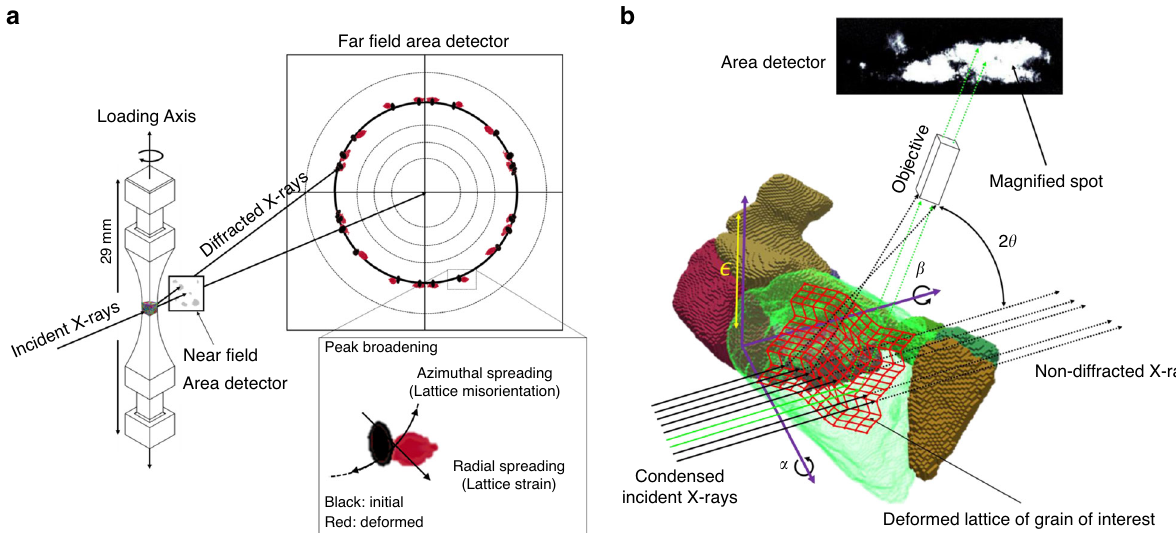
Fig. 1 X-Ray Characterization Techniques. ( a ) Schematic of HEDM setup and example of spot deformation due to macroscopic loading. ( b ) Schematic of DFXM setup. X-rays colored in green are those which both diffract and pass through the objective.